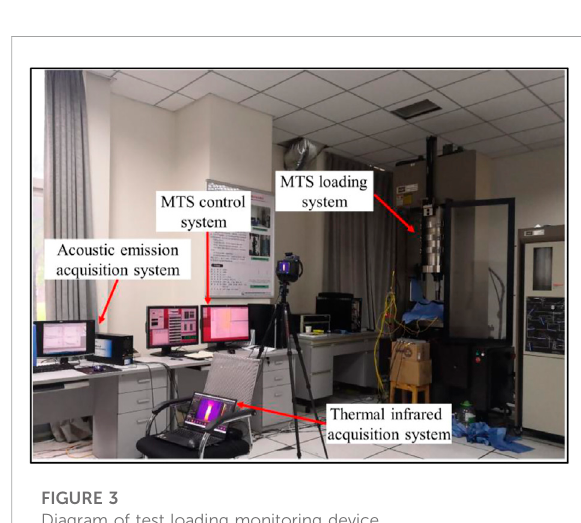
FIGURE 3 Diagram of test loading monitoring